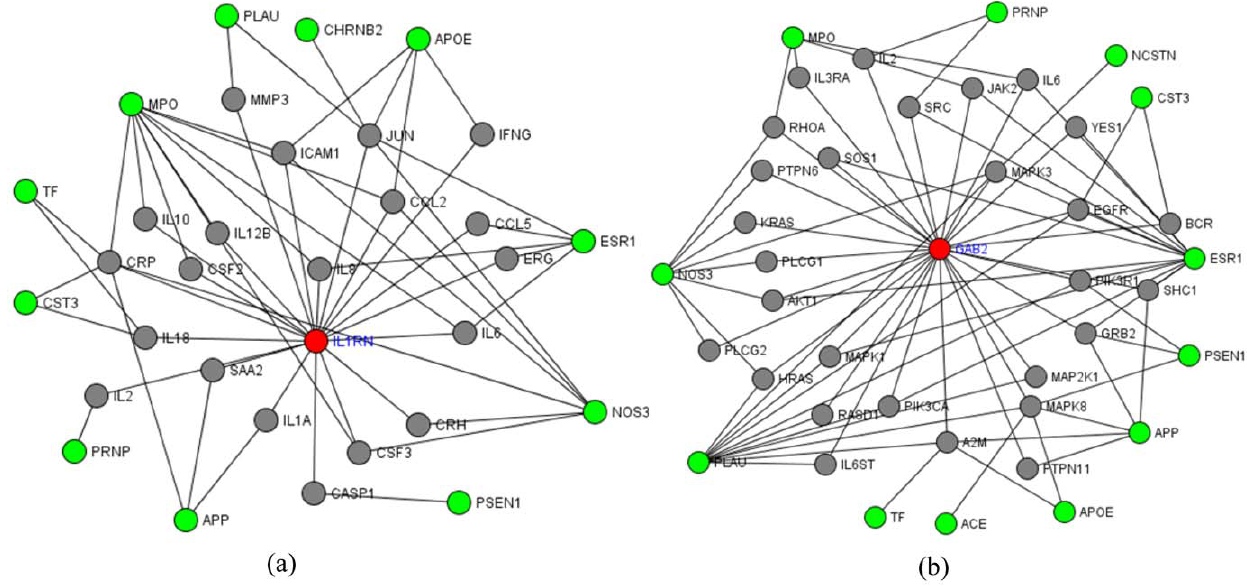
Figure 3. Three 2-level PPI sub-network enriched by IL1RN,GAB2 and important candidate genes. This figure is plotted by our tool KGG. Each node denotes a gene labeled by ‘‘Gene Symbol’’. The edge indicates a PPI between proteins encoded by two genes. The red and green nodes denote the tested genes with significant SNPs and important candidate genes respectively. Here the ‘‘2-level’’ means that the minimal length from a tested gene to an important candidate gene is 2 (edges). There are intermediate genes (in gray on the plot) between the tested gene and important candidate genes, which have PPI with the both.